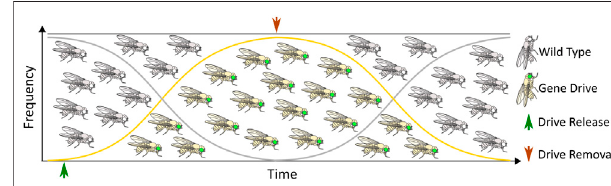
FIGURE 1 | The ideal gene drive: An autonomous homing gene drive designed to spread rapidly through a target population that is also amenable to scar-free excision leading to restoration of wild type